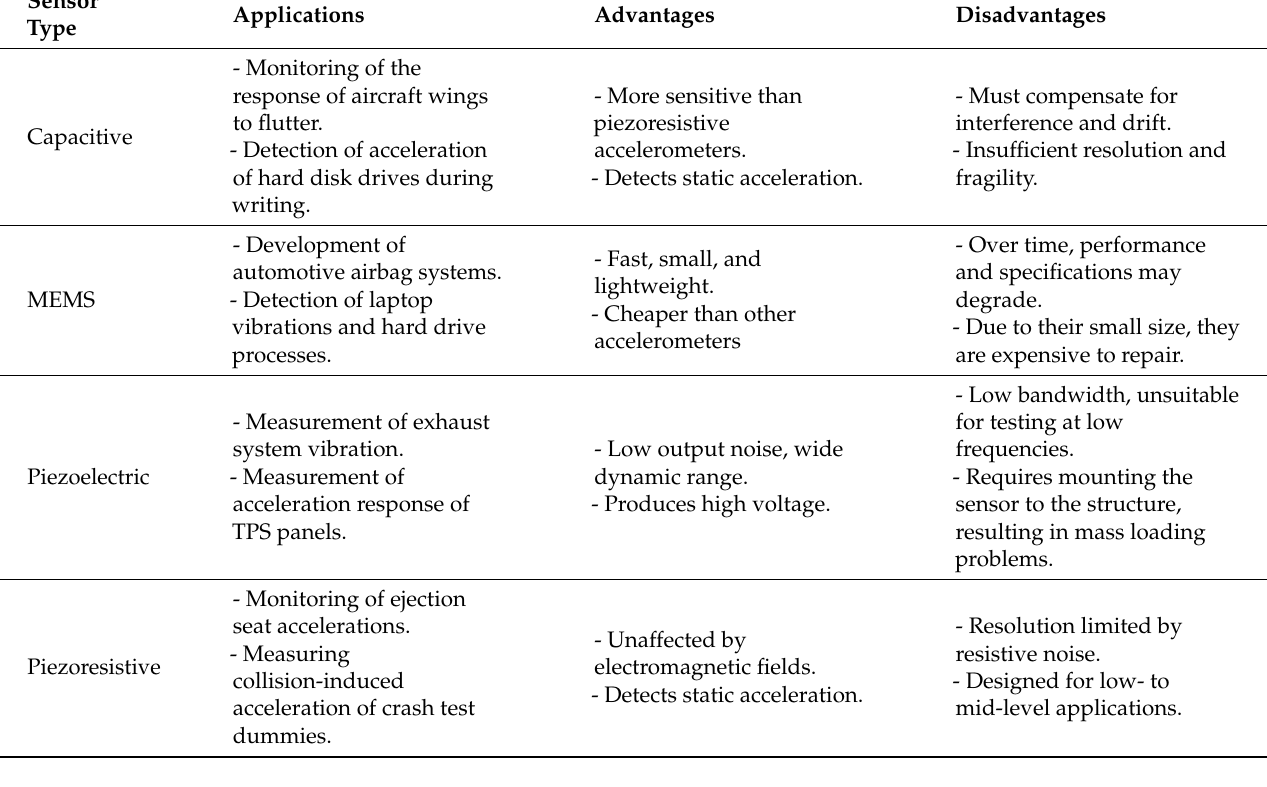
Table 20. Acceleration sensors.